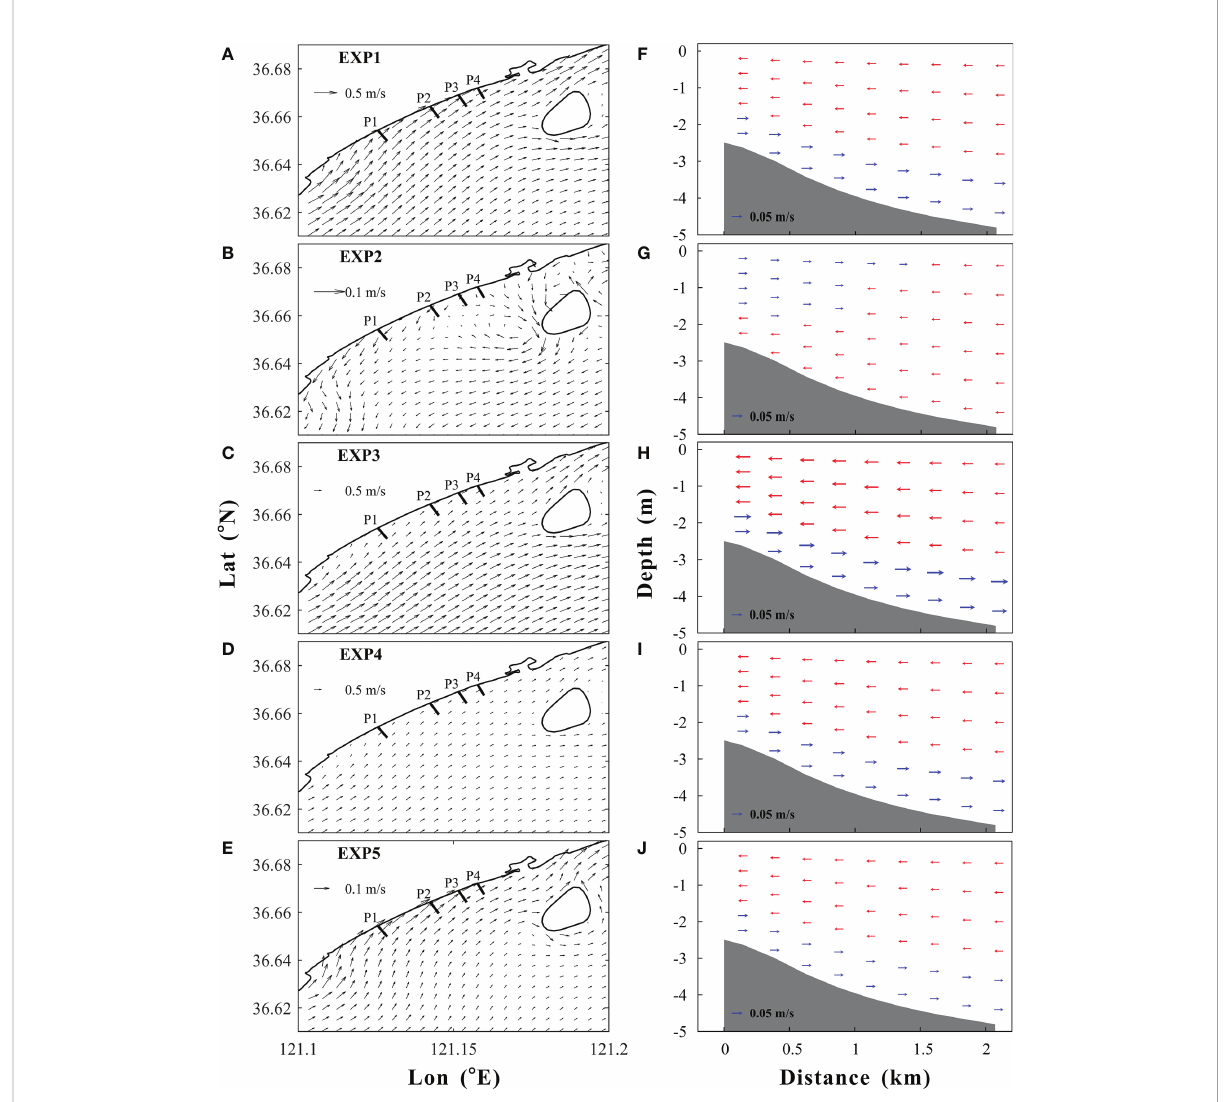
FIGURE 7 25h-averaged surface residual currents and vertical distribution of residual currents at P2 pro fi le with red arrows indicated onshore and blue arrows indicated offshore in Exp.1 (A, F) , Exp.2 (B, G) , Exp.3 (C, H) , Exp.4 ( D, I) and Exp.5 (E, J) ,